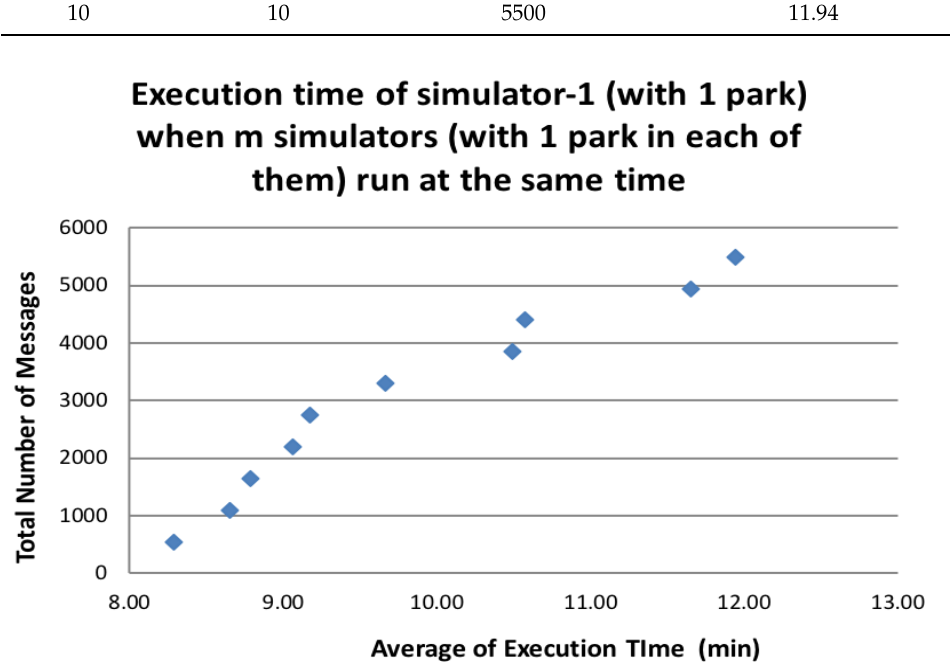
Figure 18. Experiment 2.